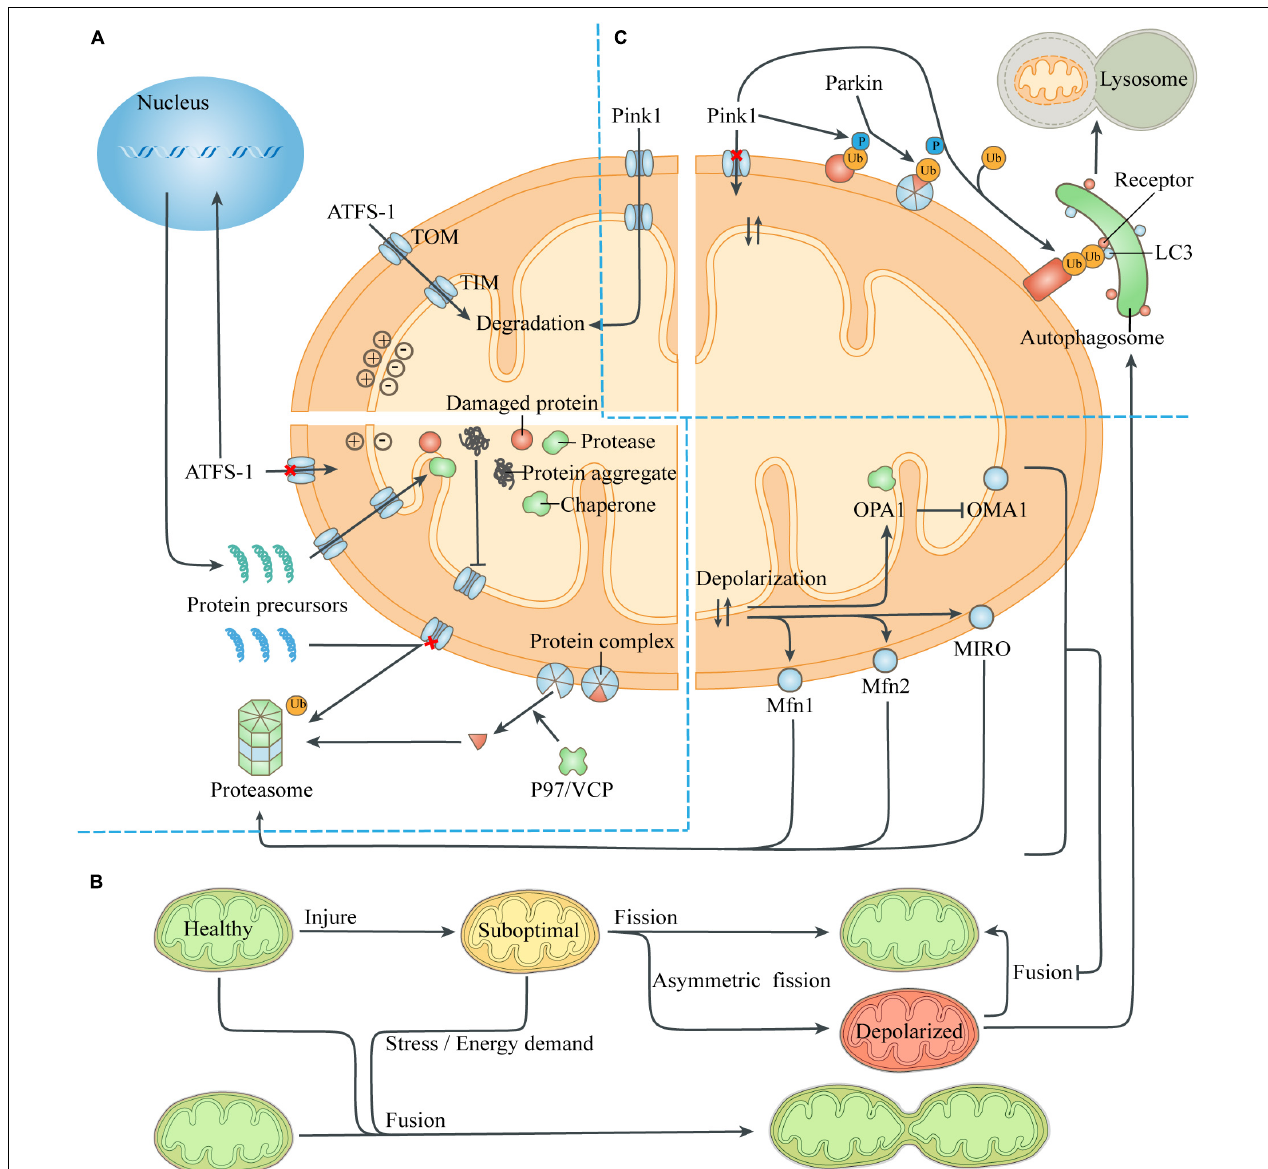
FIGURE 2 | Quality-control processes to reduce the mitochondrial burdens. (A) Maintenance of mitochondrial proteostasis. The transcription factor ATFS-1 is routinely imported to the mitochondria and degraded. The abnormal mitochondrial membrane potential caused by damaged proteins and protein aggregates leads to the transfer of ATFS-1 into the nucleus instead of the mitochondria, resulting in increased expression of mitochondrial chaperones and proteases and their entry into the mitochondria. Mitochondrial proteotoxic stress blocks the input of nuclear-encoded mitochondrial proteins, which are then degraded by the ubiquitin-proteasome system. P97/VCP isolates damaged membrane-bound proteins or proteins in complexes, thus facilitating turnover of mitochondrial proteins exposed to the cytoplasm through the proteasome. (B) Mitochondrial fusion and fission. The exchange of components during mitochondrial fusion compensates for the defects of suboptimal mitochondria, thus maintaining ATP production and resisting stress. Asymmetric mitochondrial fission helps to isolate the damaged components in the mitochondria, which are removed by mitophagy. However, severely defective mitochondria could not fuse with other mitochondria due to the degradation of fusion-related proteins. (C) Mitophagy. The loss of mitochondrial membrane potential leads to the accumulation of the kinase Pink1 on the mitochondrial surface, which phosphorylates ubiquitin on the MOM proteins and recruits the E3 ligase Parkin. Parkin induces ubiquitination of more MOM proteins, which act as a platform to recruit modifier LC3 through different autophagic receptors. Then the autophagosome engulfs the mitochondria and fuses with lysosome to digest the mitochondria. Abbreviation: TOM, translocase of the outer membrane; TIM, translocase of the inner membrane.